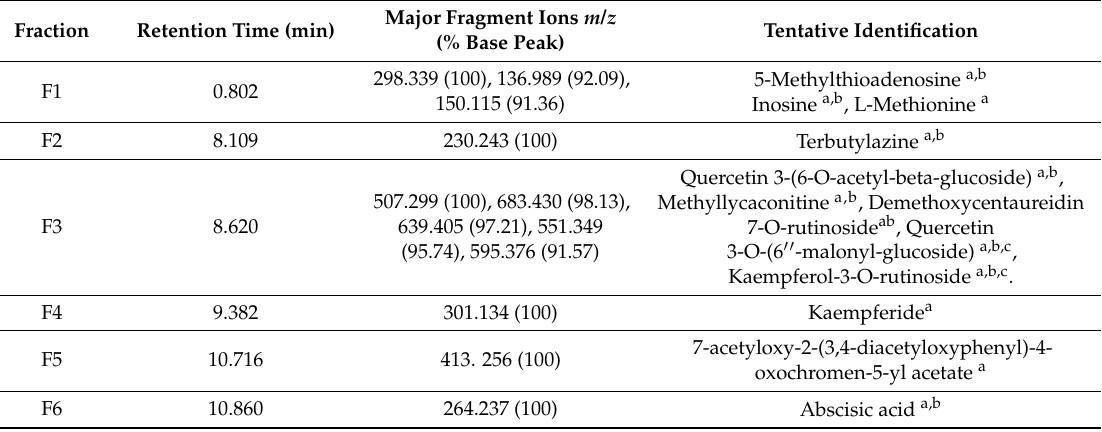
Table 4. HPLC Fractions of Polyphenol-rich extract isolated from Solieria filiformis .